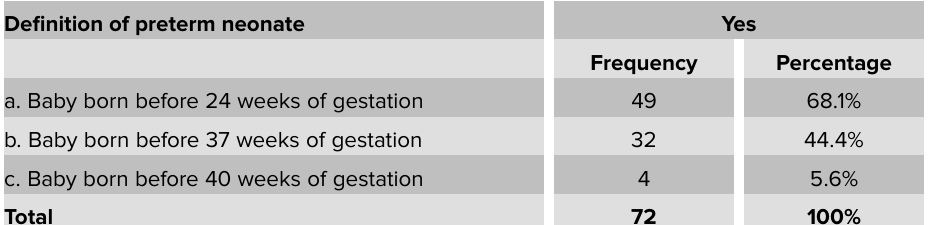
TABLE 1: Distribution of the study samples according to their knowledge regarding the definition of a preterm neonate ( N =